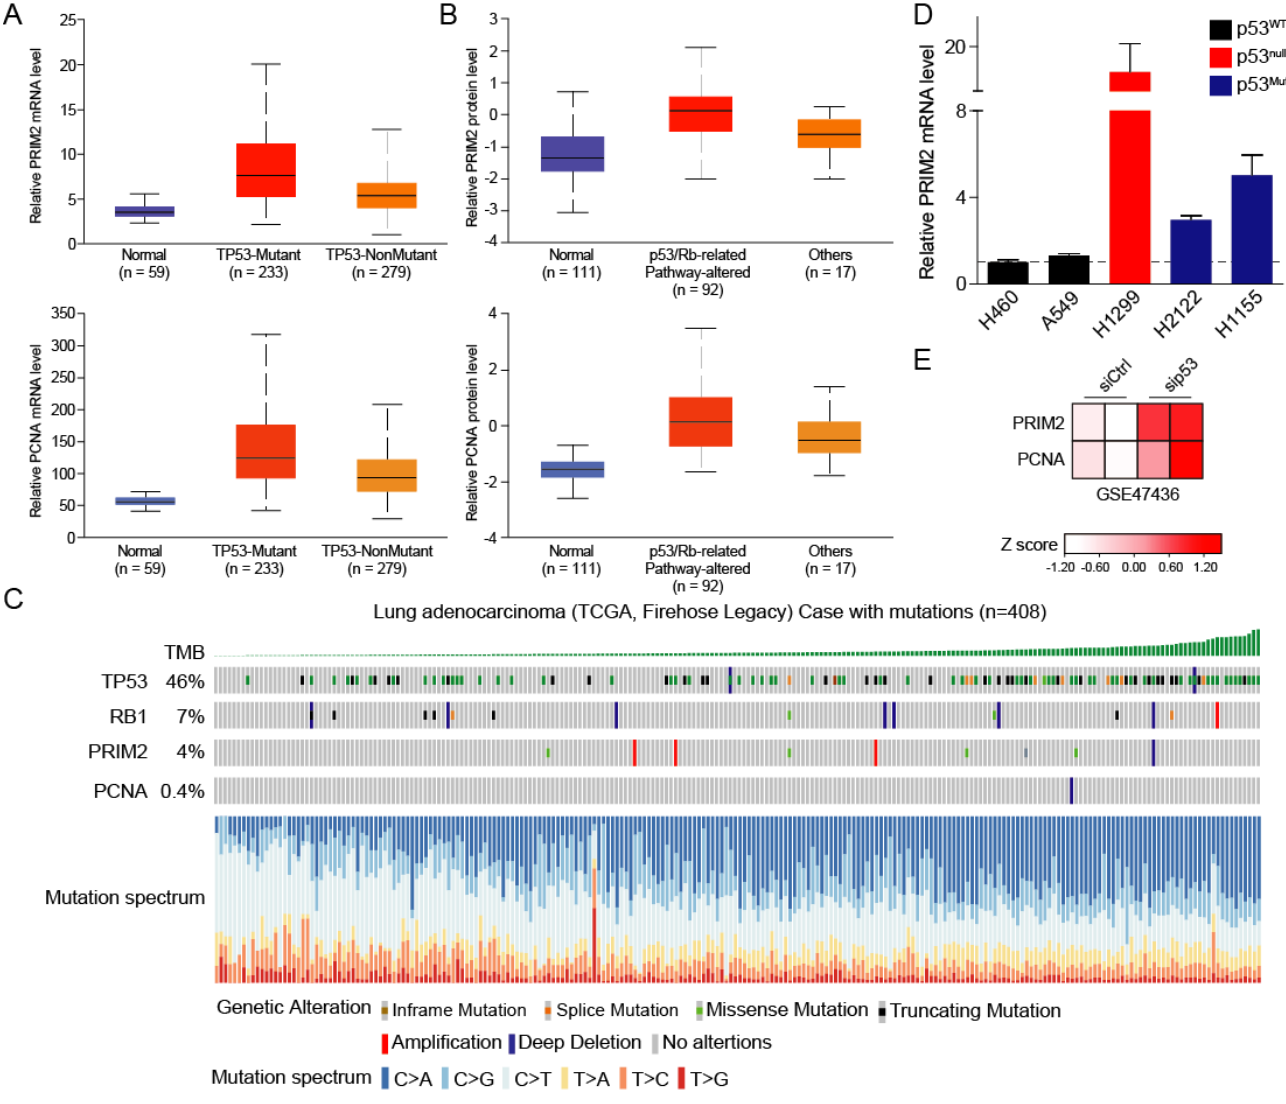
Figure 3. PRIM2 expression is associated with alteration of p53. ( A , B ) The PRIM2 mRNA and protein expression levels were analyzed among normal tissues, p53-mutant tissues, and p53-nonmutant tissues in patients with LUAD. ( C ) The types and frequencies of mutations of TP53, RB1, PRIM2, and PCNA were analyzed in LUAD patients. ( D ) The expression of PRIM2 was analyzed in different lung cancer cells. ( E ) The PRIM2 and PCNA mRNA expression levels were analyzed in airway cells with